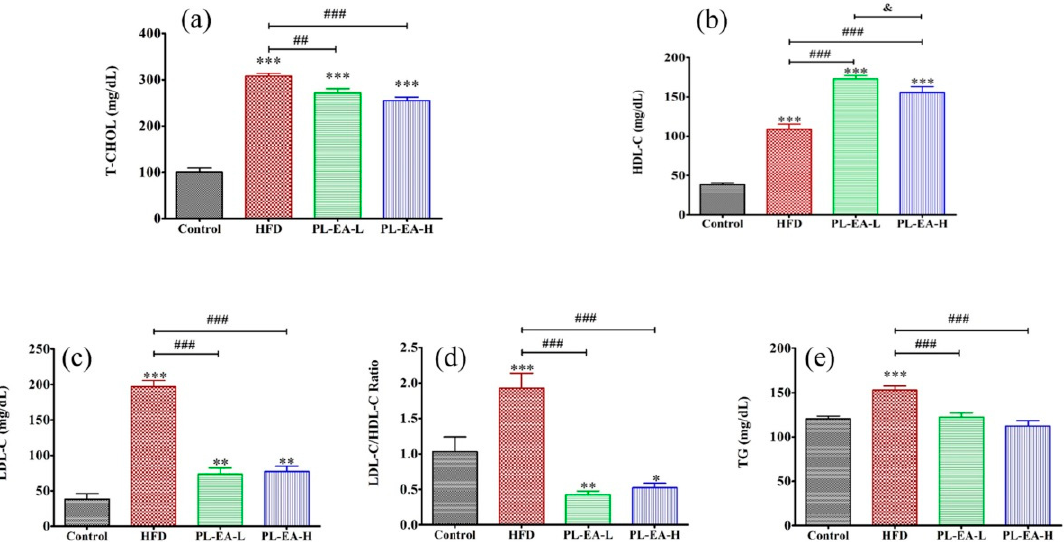
Figure 4. Effects of ethyl acetate fraction of P. linteus mycelia on the lipid profile. ( a ) total plasma cholesterol content, ( b ) content of plasma high density lipoprotein cholesterol, ( c ) content of plasma low density lipoprotein cholesterol, ( d ) the ratio LDL-C/HDL-C and ( e ) the plasma TG content. HFD: high-fat/high-fructose diet (HFD). PL-EA-L: HDF + low dose PL-EA (35 mg/kg). PL-EA-H: HDF + high dose PL-EA (70 mg/kg). Data are expressed as mean ± SE ( n = 9). ## p < 0.01; ### p < 0.001 vs. the HFD group; * p < 0.05; ** p < 0.01; *** p < 0.001 vs. the control. & p < 0.05 significant differences between the groups.